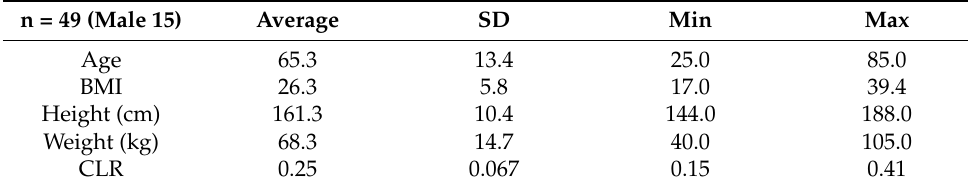
Table 1. Demographics of patients included in the study. n = 49 (Male 15)